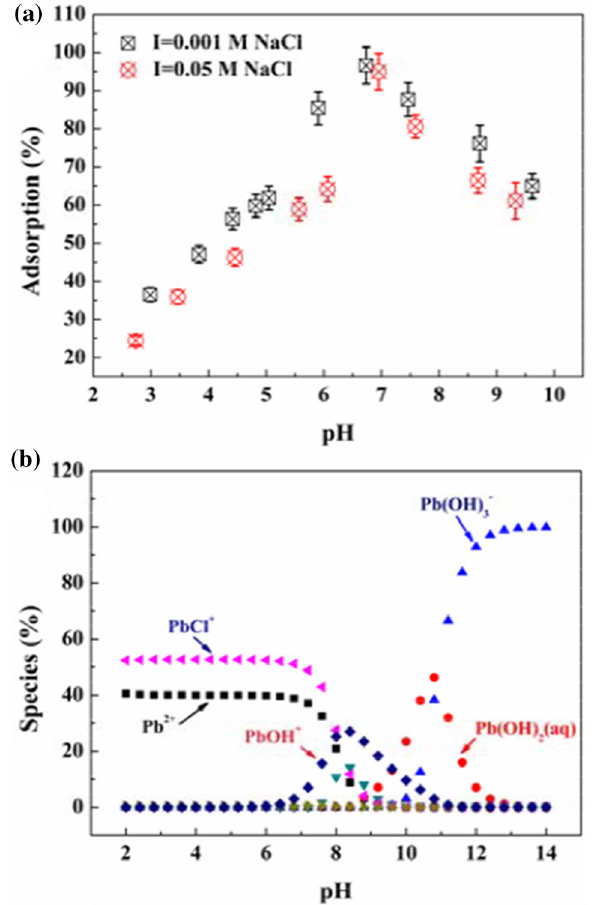
Fig. 4 The effect of contact time on the adsorption of Pb2 + on 3D AFC ( a ), and the result of adsorption property of Pb2 + by pseudo- second-order model ( b ). m/V = 0.4 g/L, [Pb2 +]0 = 4.8 × 10–4 mol/L, pH = 5.5 ± 0.1, I = 0.001 M NaCl, T = 25 °C